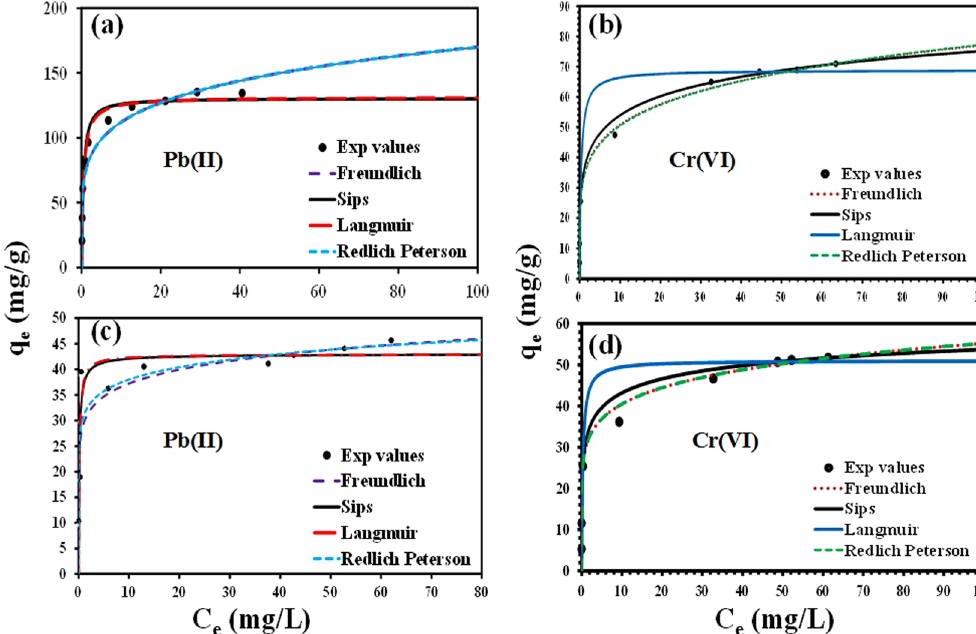
Figure 7. Adsorption isotherms of Pb(II) and Cr(VI) ions adsorption by ( a , b ) PG-C and ( c , d ) CNF-C nanocomposites and fitting of different isotherm models to the experimental